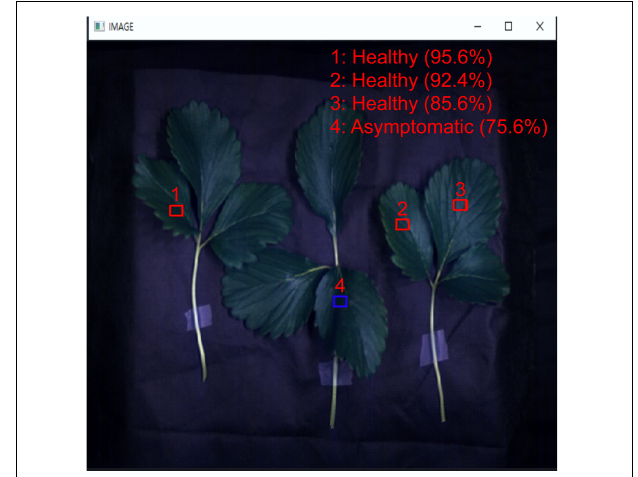
FIGURE 15 | Program that loads hyperspectral images and diagnoses the infection state of the corresponding areas manually (through the user clicking on the